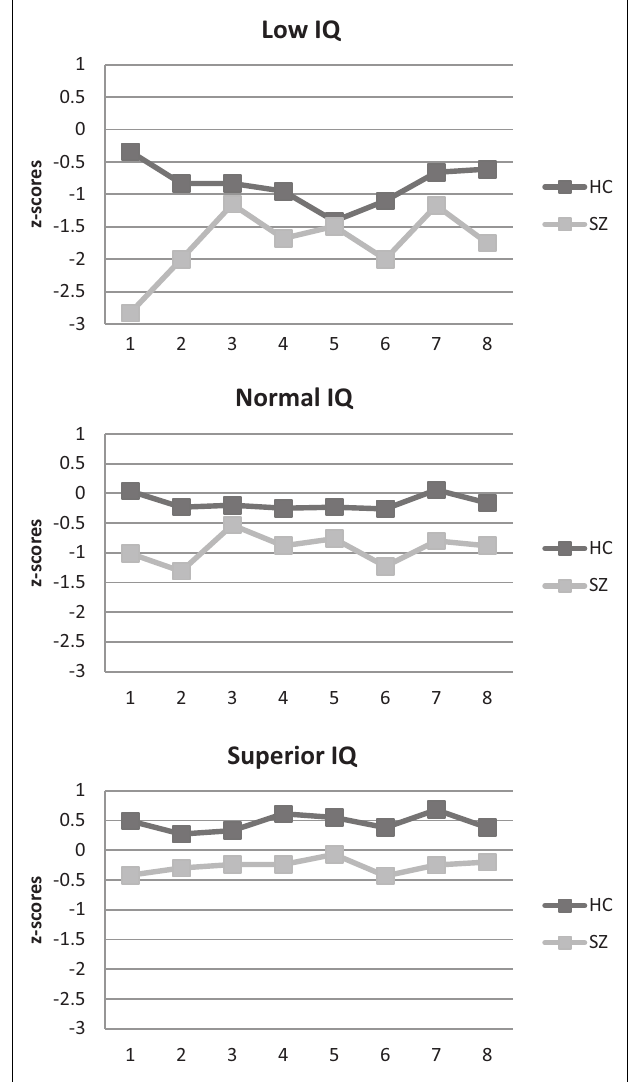
FIGURE 1 | Neuropsychological profile of schizophrenia and healthy participant groups . (1) Fine motor function/Grooved PegboardTest; (2) psychomotor speed/digit symbol; (3) attention/digit span; (4)Verbal learning/Logical MemoryTest; (5) phonemic fluency/letter fluency; (6) semantic fluency/category fluency; (7) cognitive flexibility/category switching; (8) inhibition/“Stroop” z -scores were calculated based on the performance of HC group